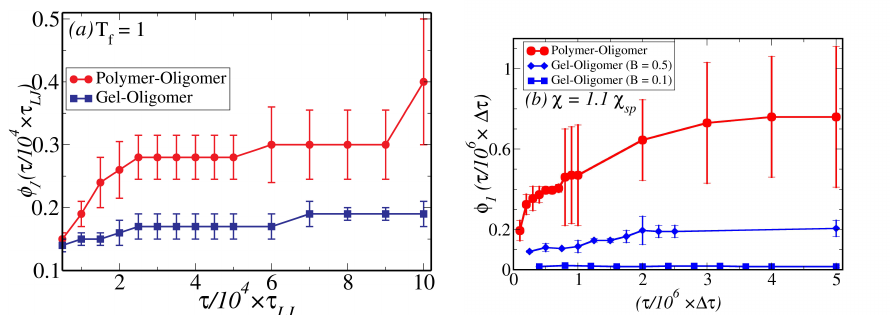
Figure 5. The fraction of migrant molecule computed from an MD simulation of a polymer–oligomer mixture and a gel–oligomer mixture is shown in ( a ), while ( b ) shows the same from a meso-scale mixture of a polymers and oligomers and a mixture of gel and oligomers for two values of gel bulk